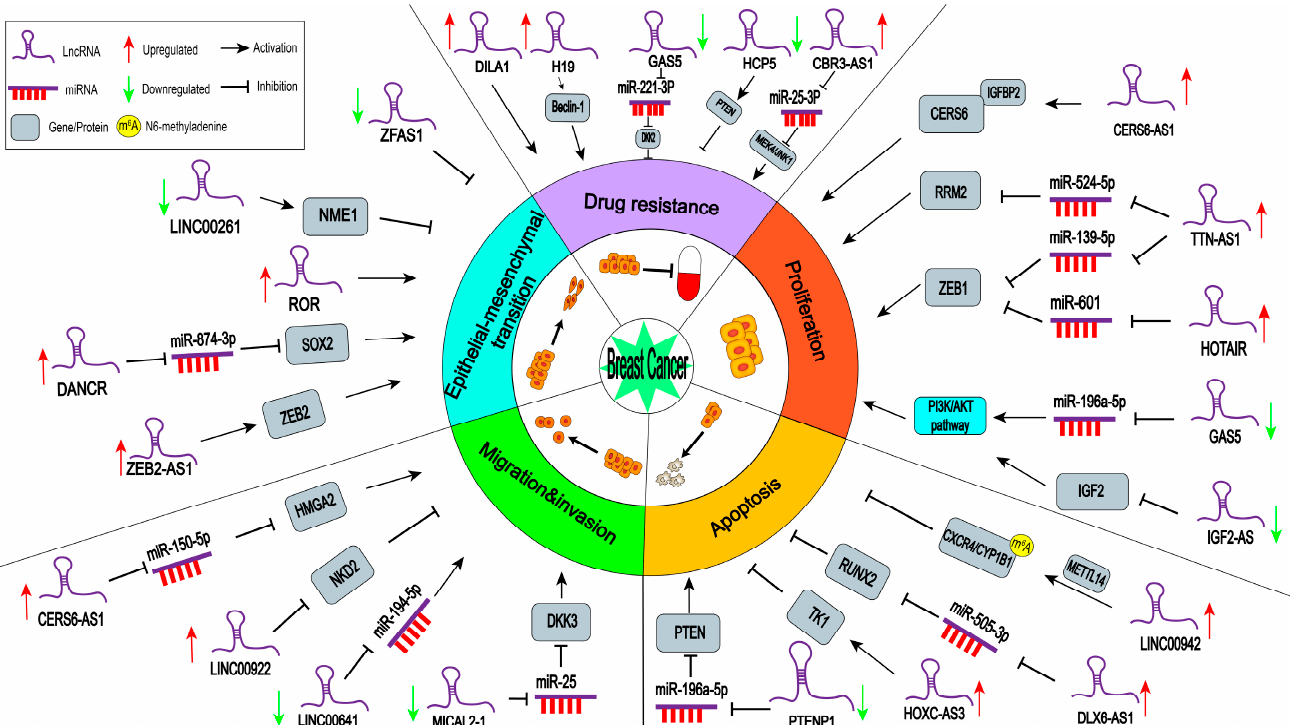
Figure 1. The roles and molecular mechanisms of lncRNAs in breast cancer. Selected lncRNAs have been found to be involved in breast cancer by affecting cell proliferation and apoptosis, cell migration and invasion, epithelial–mesenchymal transition (EMT), and drug resistance by manipulating those related target genes and signaling pathways. Abbreviations: CERS6 , ceramide synthase 6; CXCR4 , chemokine receptor 4; CYP1B1 , cytochrome P450 1B1; DKK2 , dickkopf 2; DKK3 , dickkopf 3; HMGA2 , high-mobility group protein 2; IGFBP2, insulin-like growth factor binding protein-2; IGF2, insulin like growth factor 2; m 6 A, N6-methyladenine; METTL14, methyltransferase-like 14; NKD2 , naked cuticle homolog 2; NME1 , NME/NM23 nucleoside diphosphate kinase 1; PTEN , phosphatase and tensin homolog; RRM2 , ribonucleotide reductase subunit 2; RUNX2 , runt-related transcription factor 2; SOX2 , SRY-Box 2; TK1 , thymidine kinase 1; ZEB1 , zinc finger E-box binding homeobox 1; ZEB2 , zinc finger E-box binding homeobox 2. Table 1. Regulatory roles and clinical features of representative lncRNAs in breast cancer.